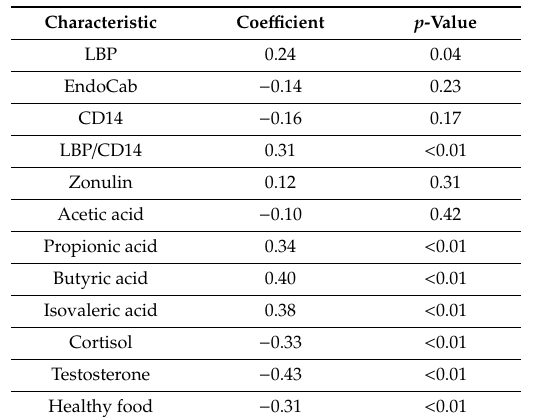
Table 2. Associations between body mass index (BMI) and other biomarkers.